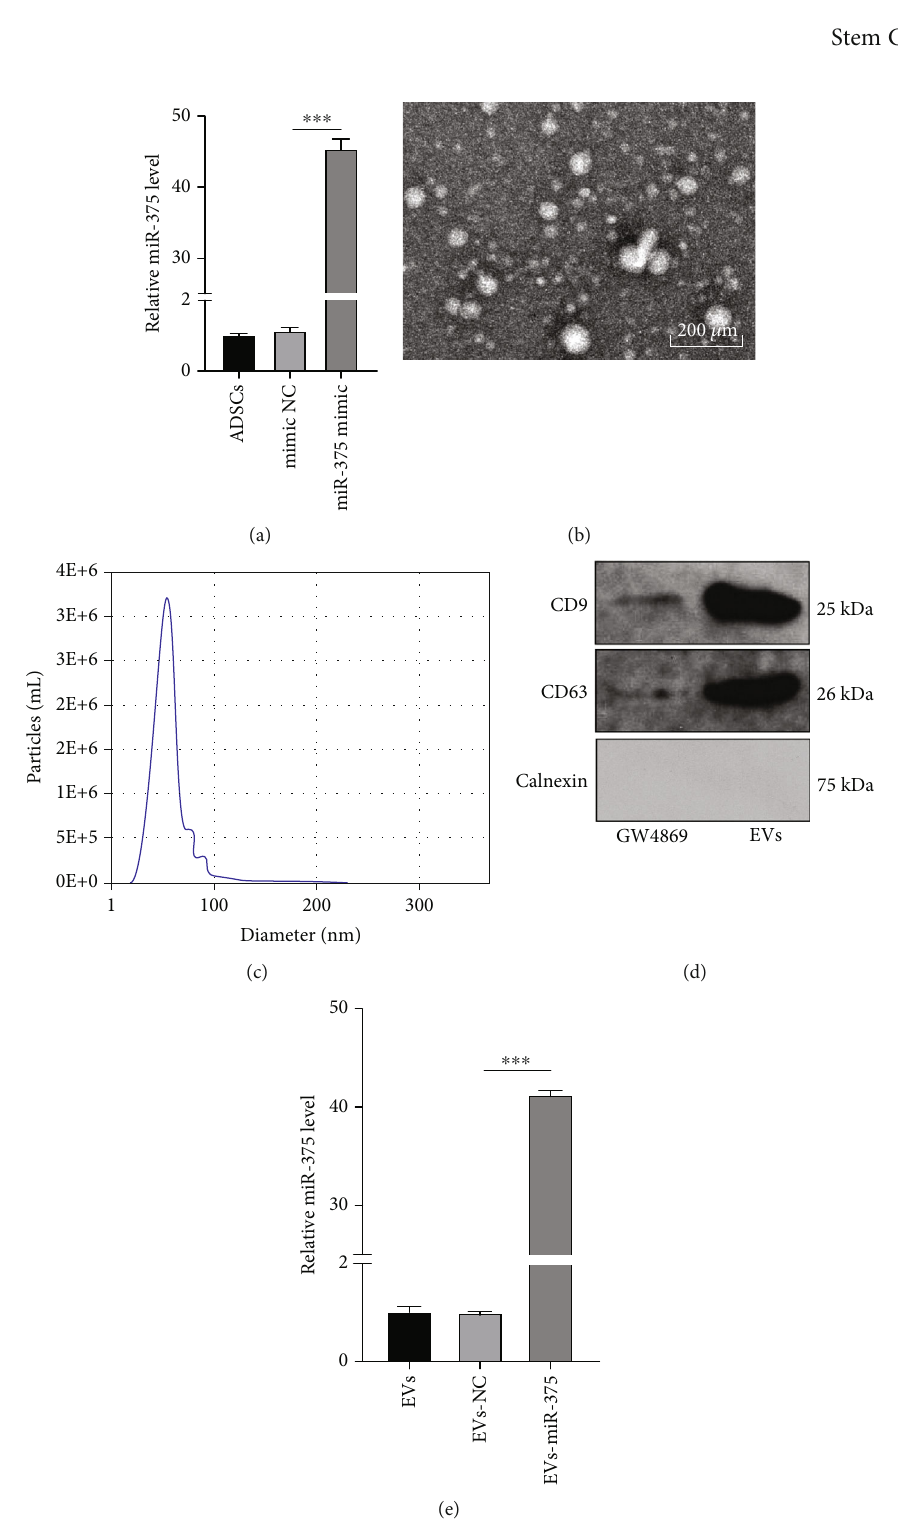
Figure 2: ADSC-EVs are successfully extracted. (a) ADSCs were transfected with miR-375 mimic or NC mimic, and the EVs (EVs-miR- 375/EVs-NC) and EVs from ADSCs were extracted; the transfection e ffi ciency was detected using RT-qPCR. (b) ADSC-EVs were separated and puri fi ed using ultracentrifugation methods, and their morphology and size of ADSC-EVs were analyzed under the TEM. (c) The particle size of EVs was measured using NanoSight. (d) The expression of CD9, CD63, and calnexin was detected using WB. GW4869: treatment of ADSC conditioned medium supplemented with EV inhibitor GW4869; EVs: treatment of ADSC-EVs. (e) miR-375 expression in EVs was detected using RT-qPCR. The experiment was repeated 3 times, and the data were expressed as mean ± SD . Comparison among multiple groups was analyzed using one-way ANOVA, followed by Tukey ’ s multiple comparisons test. ∗∗∗ P < 0 : 001